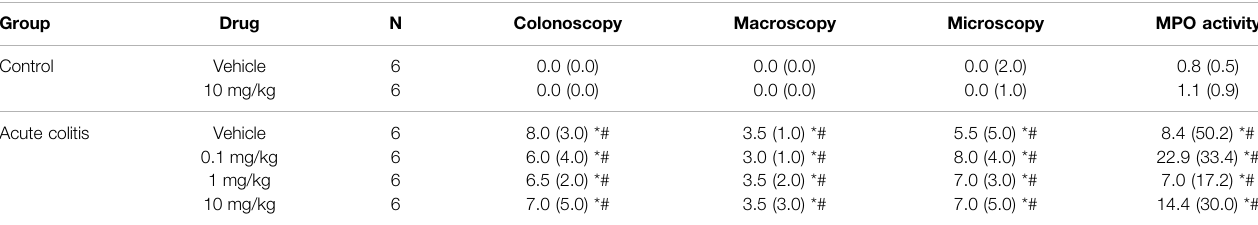
Holm p -value = 0.065, Figure 2C ). In a dose of 10 mg/kg, nafamostat